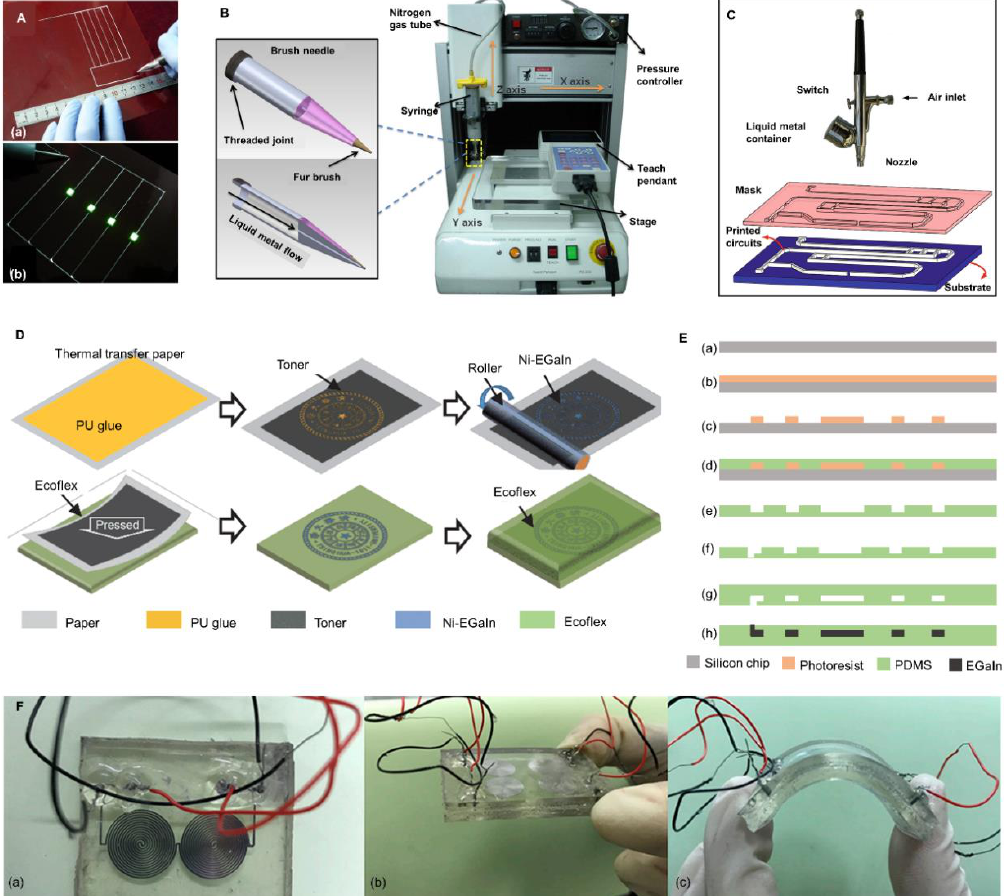
Figure 3. Printing and microfluidic technology. ( A ) Printing circuits with liquid metal ink by a roller ball pen, reproduced with permission from [82]. ( B ) Mechanical printing of liquid metal circuits with desktop printer, reproduced with permission from [84]. ( C ) Schematic of patterning liquid metal with a rigid mask, reproduced with permission from [90]. ( D ) Schematic of patterning liquid metal with toner mask, reproduced with permission from [72]. ( E ) Schematic of microfluidic technology: ( a ) The silicon chip; ( b ) Silicon chip coated by photoresist; ( c ) Lithography model; ( d ) Pouring PDMS; ( e ) PDMS with micro-grooves; ( f ) Punching; ( g ) Plasma bonding; ( h ) Injecting liquid metal. ( F ) A stretchable pressure sensor fabricated by the microfluidic technology: ( a ) Vertical view of the pressure sensor; ( b ) Original state of the pressure sensor; ( c ) A pressure sensor under bending; Reproduced with permission from [96].